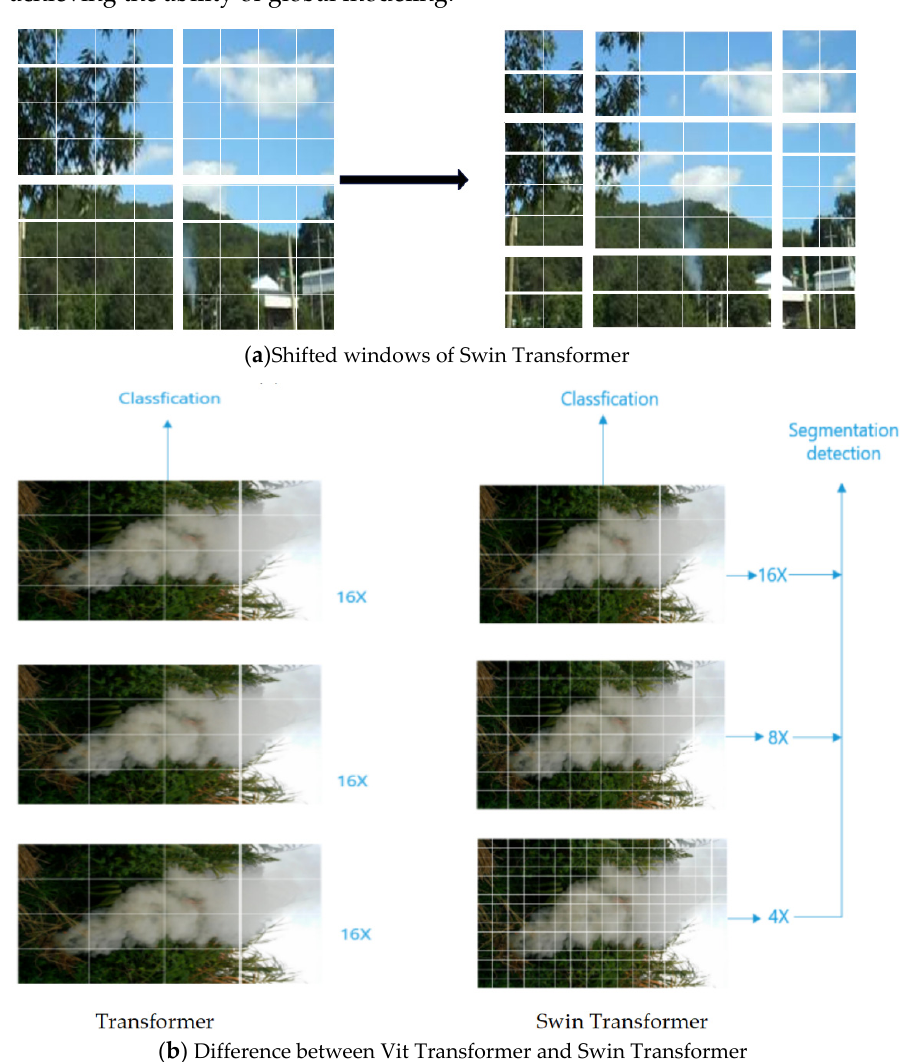
Figure 3. Window operations of Swin Transformer ( a ) Through W-MSA, self-attention is calculated within each local window, and the shifted window enables the interaction between two adjacent windows and achieves the ability of global modeling. ( b ) The Vit Transformer generates a single low-resolution feature map, which has quadratic computational complexity in the input image size; Swin Transformer is based on the characteristics of W-MSA and SW-MSA, and can merge image patches in deeper layers, and the calculation of self-attention is performed in each local window, so it has linear computational complexity.